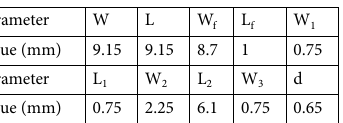
Table 1. Parameter values of the array design with SCA